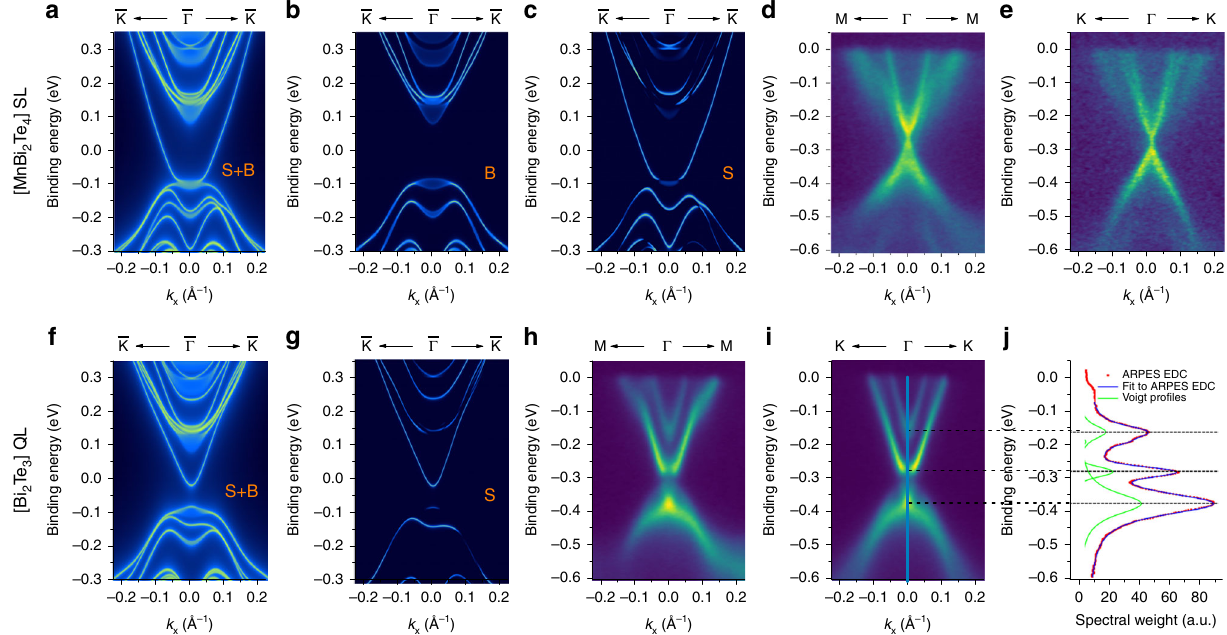
Fig. 4 Comparison between ARPES-measured and DFT-calculated surface states. a – c The DFT-calculated k-E map along (cid:1) K SL termination: a surface and bulk (S + B) spectrum, b bulk only, and c surface only. d , e The experimental ARPES spectrum on the [MnBi 2 Te 4 ] SL (cid:1) Γ ! (cid:1) K on the [Bi + B) spectrum, g surface only. h , i The experimental ARPES spectrum on the 2 Te 3 ] QL termination: f surface and bulk (S [Bi 2 Te 3 ] QL termination obtained with 47 eV, linear horizontal light: h along Μ ← Γ → Μ , i along Κ ← Γ → Κ high symmetry direction. j The EDC plot at the Γ point (blue-line cut in i ) showing three main peaks corresponding to the bulk conduction band, surface conduction band, and mixed surface/bulk valence band. The green curve shows the fi tted Voigt pro fi le peaks which sum to the blue